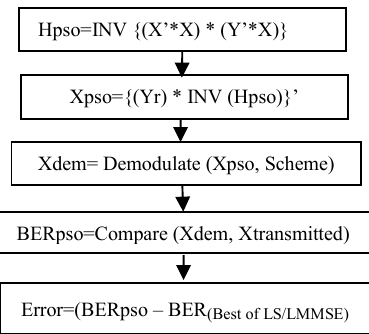
Figure 3: Calculation of PSO fitness value and Error in